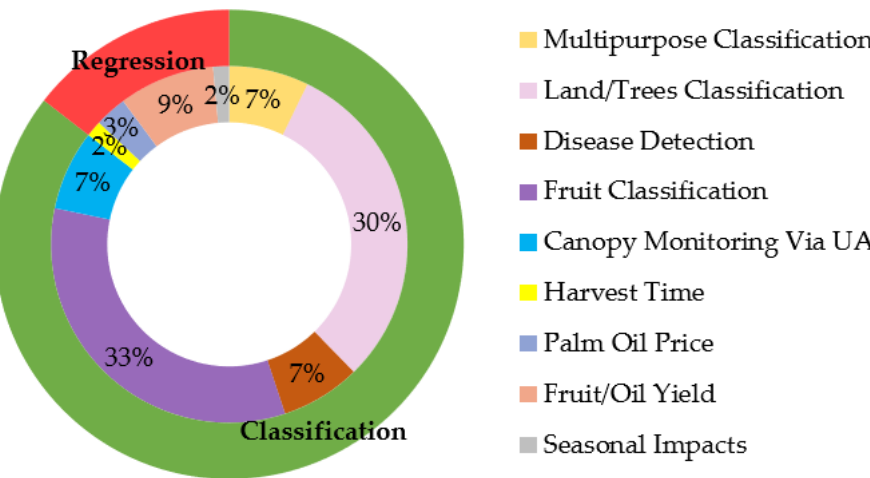
Figure 4. Articles categories and objective-based distribution.